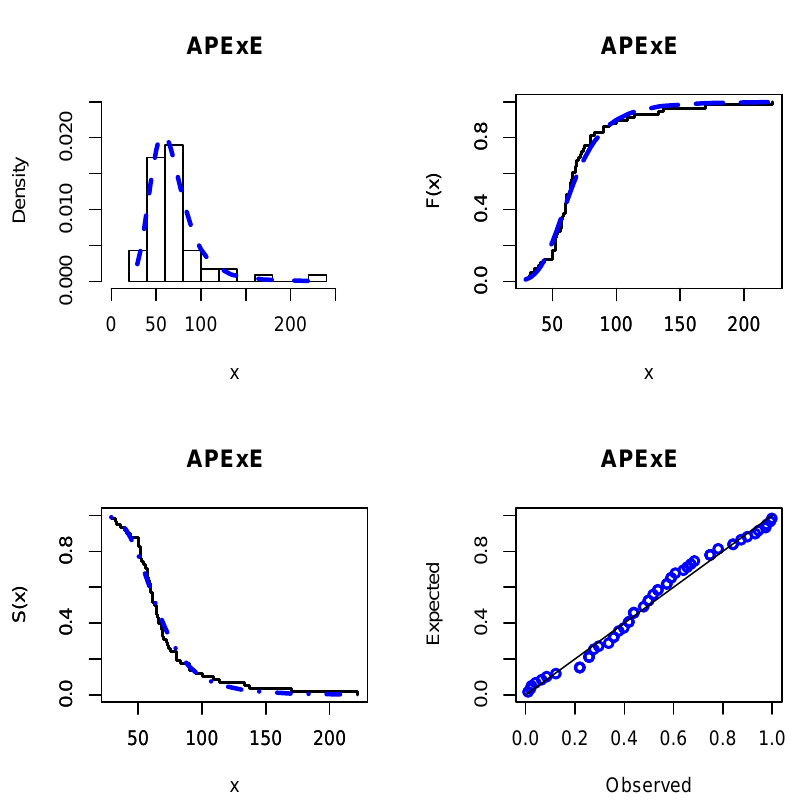
Figure 6. The fitted APExE PDF, CDF, SF, and P–P plots for insurance data.